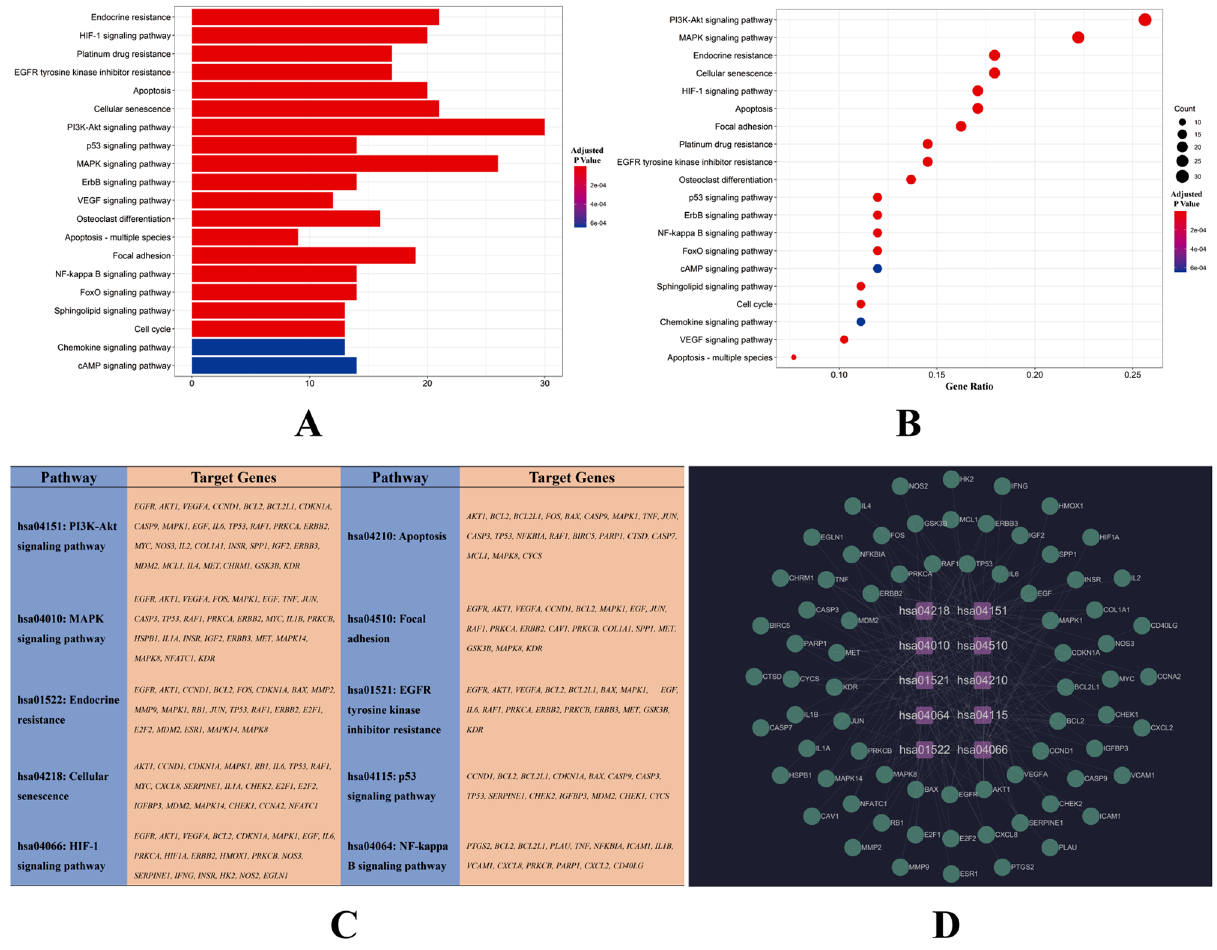
Figure 4. Results of KEGG enrichment analysis and key pathway network construction 19–21 . ( A ) and ( B ) Column chart and bubble chart of pathways highly relevant to the treatment effects of QC. ( C ) Top 10 signaling pathways by gene ratio and their related target genes. ( D ) KEGG key pathway network based on KEGG enrichment